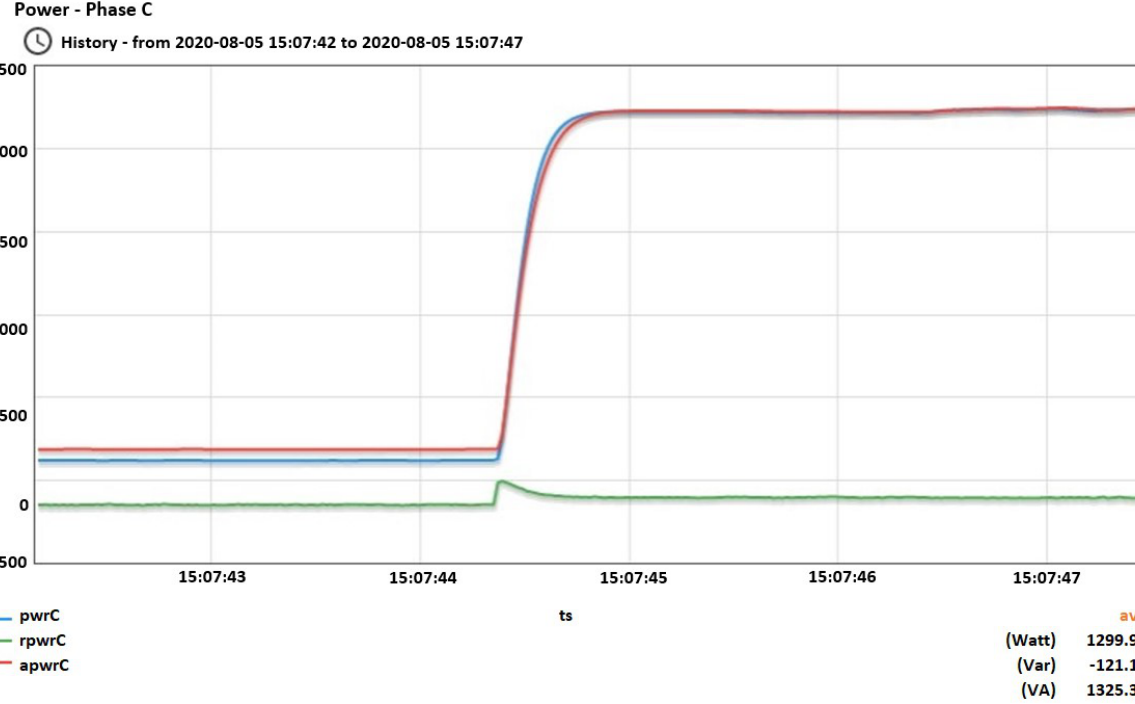
Figure 17. Press’